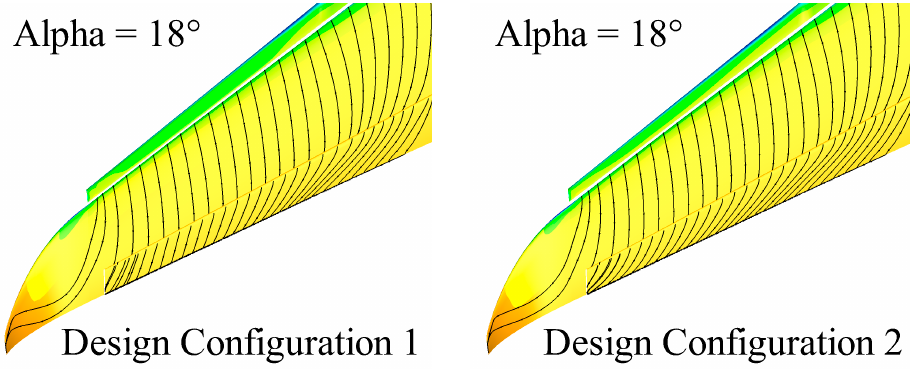
Figure 26. Surface limiting streamlines of Design Configuration 1 and Design Configuration 2.